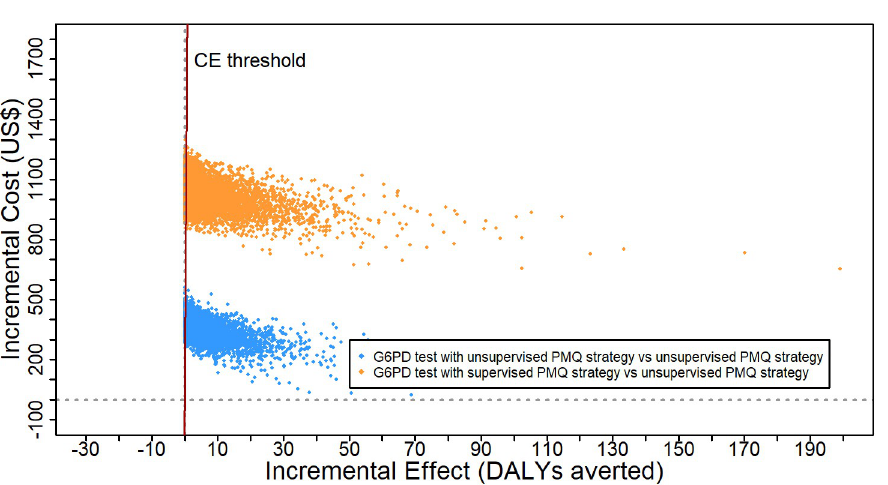
Fig 11. Probabilistic sensitivity analysis result for incremental cost-effectiveness of G6PD test with unsupervised PMQ strategy or G6PD test with supervised PMQ strategy, both compared against unsupervised PMQ strategy.